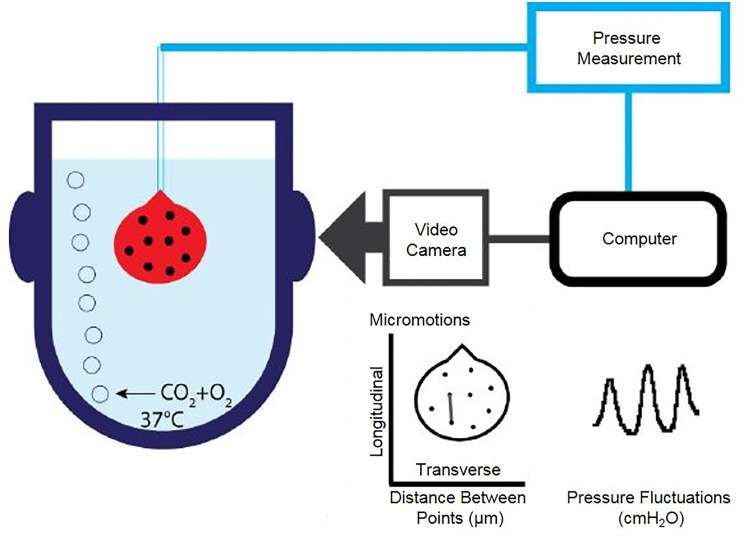
Schematic diagram of isolated whole organ apparatus recording pressure and bladder wall movements simultaneously. Catheterised bladder is placed upside down in carboxygenated buffer in a jacketed chamber held at 37°C. Pressure transducer attached to catheter is connected to an analogue to digital converter. Filming of the bladder is synchronised to pressure recordings.